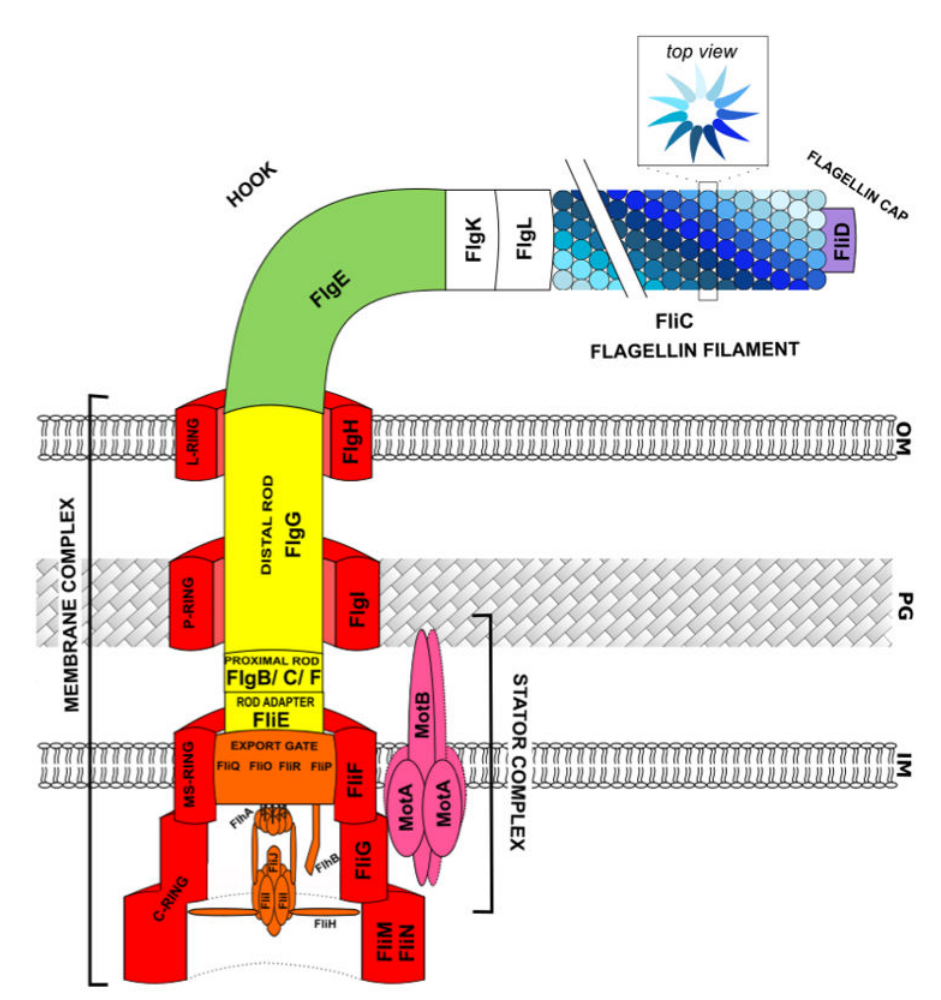
Figure 1. Schematic representation of the structure of the flagellar apparatus. IM, PG, and OM correspond to the inner membrane, peptidoglycan layer, and outer membrane, respectively. The flagellar membrane complex is composed of the basal body (in red), flagellar type 3 secretion system (in orange), and rod structure (in yellow). The flagellar filament (in various shades of blue) is connected to the hook (in green) by two junction proteins (in white). The flagellin cap (in purple) is the only cap protein that remains attached to the flagellar structure. The stator complex (in pink) is anchored to the peptidoglycan layer and interacts with the C-Ring to generate flagellar rotation. The basal body (represented in red in Figure 1) is composed of the C, MS, P, and L